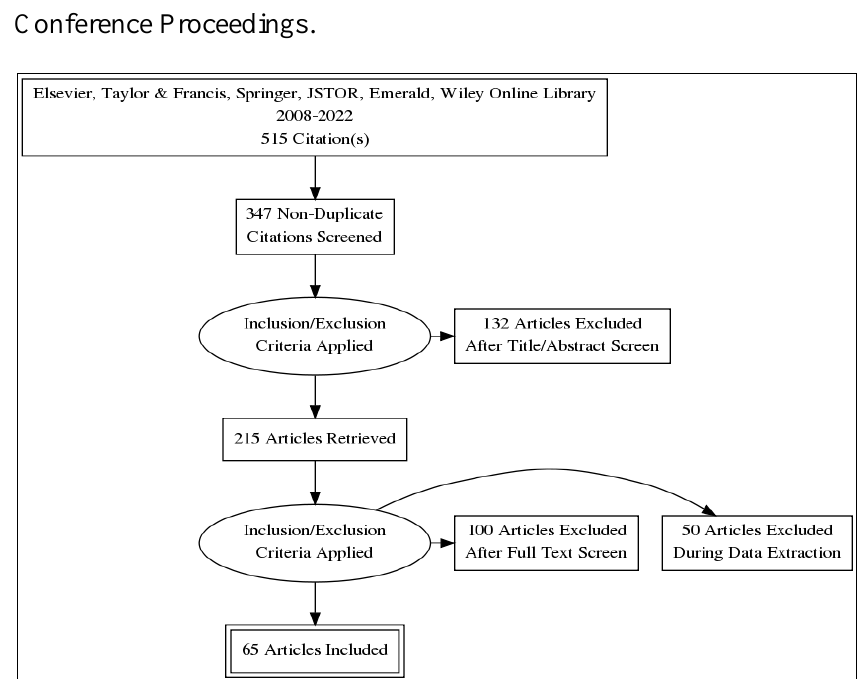
Figure.1.PRISMA